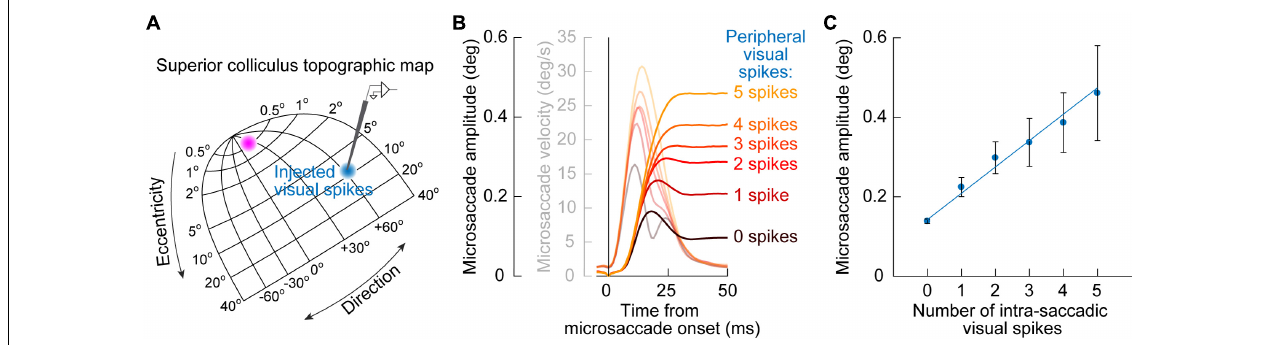
FIGURE 5 | Quantitative link between microsaccade endpoint variability for early cue-induced microsaccades and the number of peripheral cue-induced SC visual spikes. (A) After cue onset, a visual burst is emitted in the peripheral SC representation (blue population of neurons on the SC topographic map). The timing of these visual burst spikes coincides with the timing of early cue-congruent microsaccades (e.g., Figure 1B ). This might suggest that the impact of the SC on early microsaccade directions (as predicted from Figure 3 ) is mediated by readout, by downstream structures, of cue-induced visual spikes in the SC as if they were part of the simultaneously occurring movement spikes in the rostral SC (magenta population). (B) Consistent with this, cue-congruent microsaccades are larger in size than baseline microsaccades (Hafed and Ignashchenkova, 2013; Tian et al., 2016). More critically, the increase in size is deterministically related to the number of peripheral cue-induced SC spikes. The more “visual” spikes in a recorded peripheral SC neuron at the cued location, the larger the microsaccade. Faint colors also show microsaccade velocity profiles. (C) This relationship between cue-induced visual spikes in the SC and early cue-induced microsaccade amplitudes is linear for movements toward the cue (the great majority of movements shortly after cue onset). Thus, every spike of every active cue-driven SC neuron contributes to microsaccade endpoint variability. Adapted with permission from Buonocore et al. (2020b).